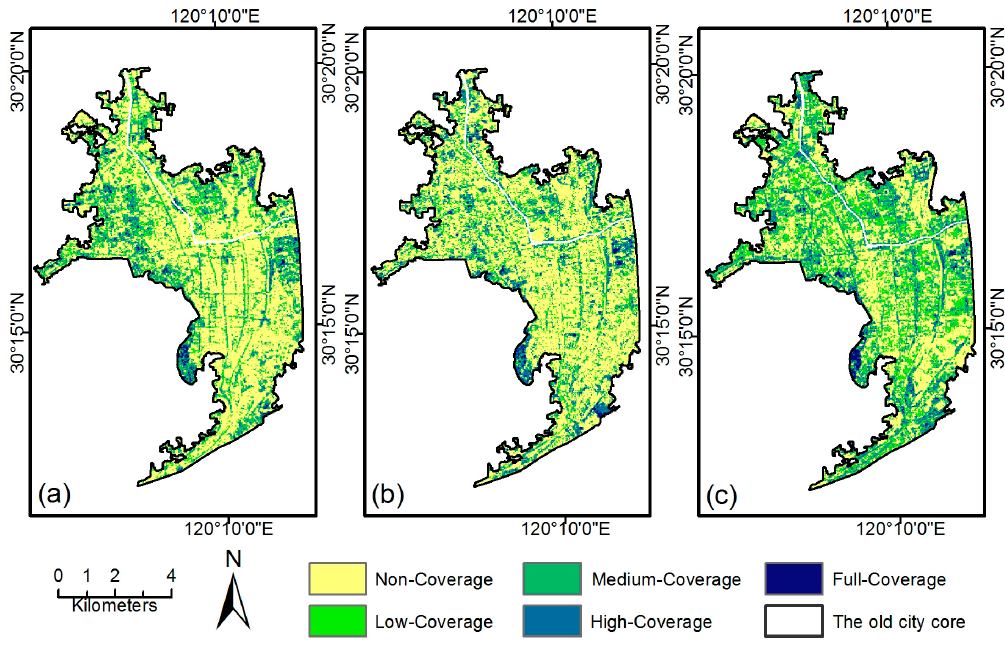
Figure 5. Vegetation coverage class maps of the city core for ( a ) 1990, ( b ) 2002, and ( c ) 2013.